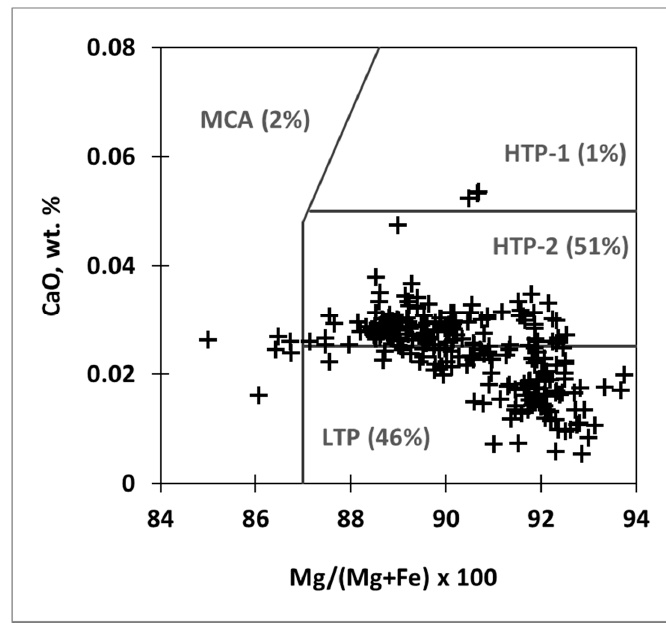
Figure 10. Pluses are compositions of olivines from Aikhal kimberlite (Alakit kimberlite field, central Siberian craton). Note, that MCA = 2%. See supplementary Table S1.